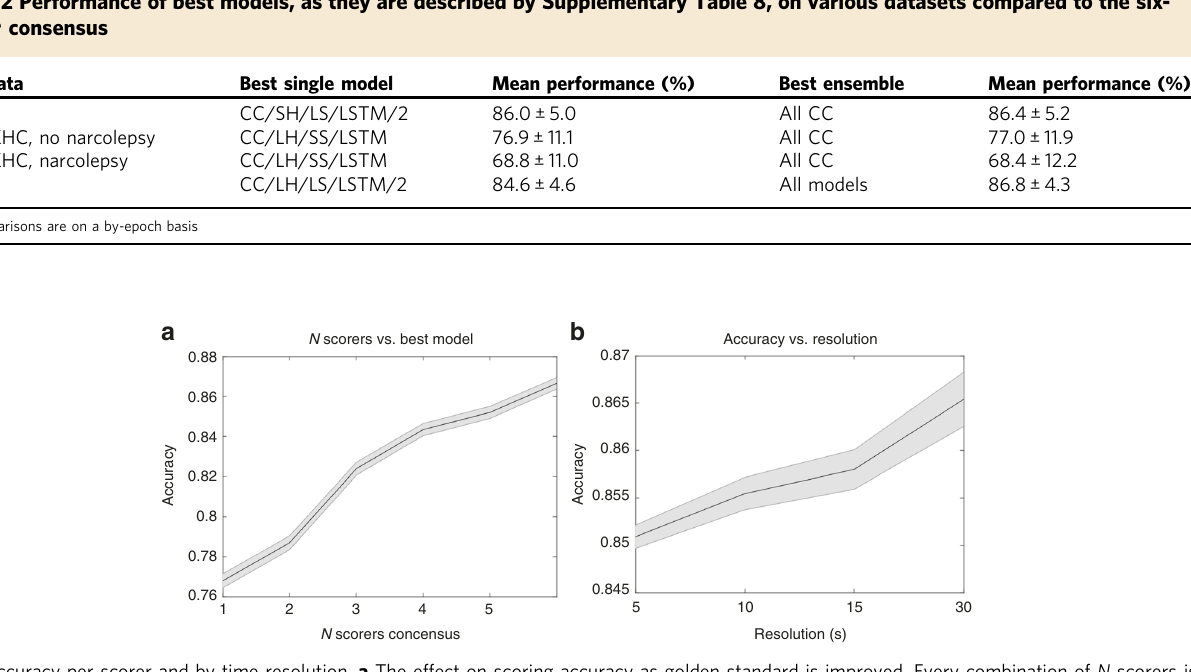
Fig. 1 Accuracy per scorer and by time resolution. a The effect on scoring accuracy as golden standard is improved. Every combination of N scorers is evaluated in an unweighted manner and the mean is calculated. Accuracy is shown with mean (solid black line) and a 95% con fi dence interval (gray area). b Predictive performance of best model at different resolutions. Performance is shown as mean accuracy (solid black line) with a 95% con fi dence interval (gray